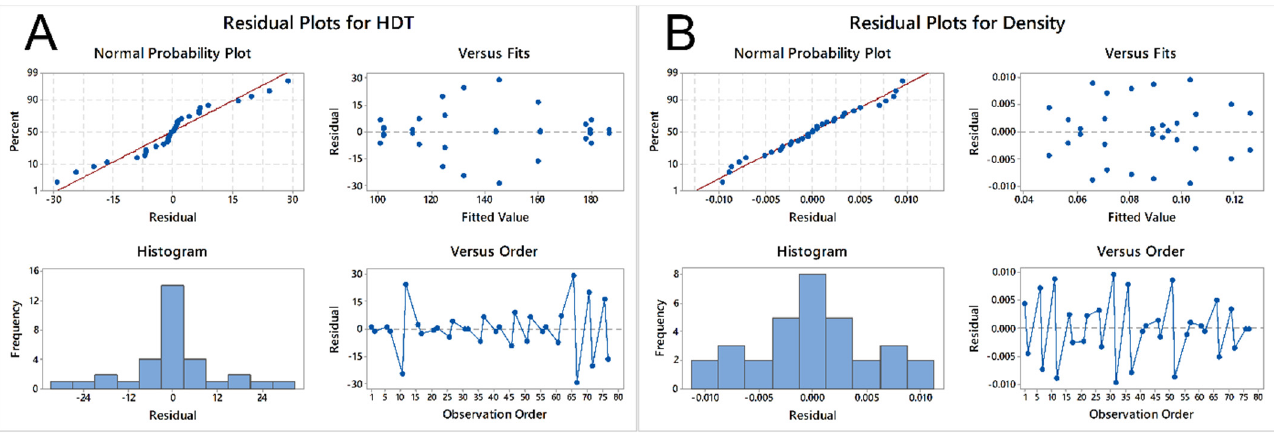
Figure 3. Residual plots for ( A ) HDT and ( B ) density.